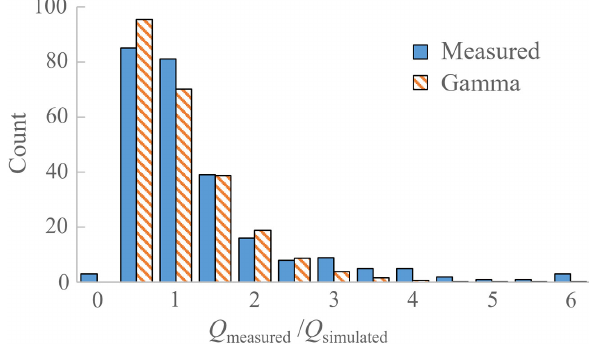
FIG. 6. Measured and simulated quality factor ratio distribution for the lowest two dipole passbands in MESA cavity compared to